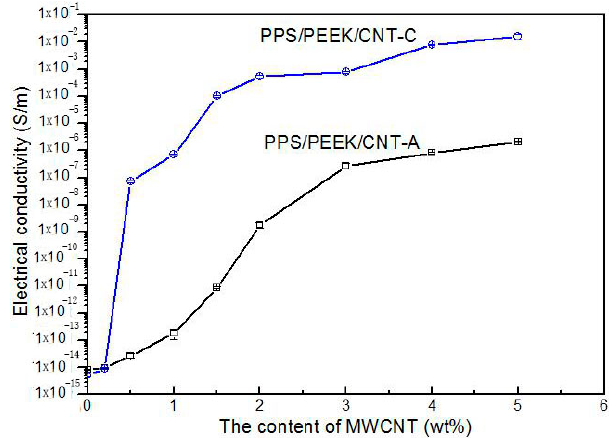
Figure 4. Variations of electrical conductivity of PPS/PEEK/MWCNT nanocomposites with different